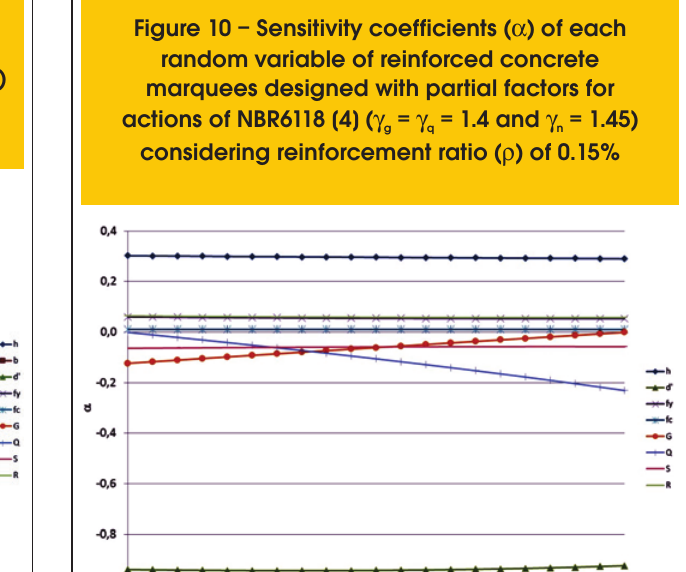
Figure 10 – Sensitivity coefficients ( a ) of each random variable of reinforced